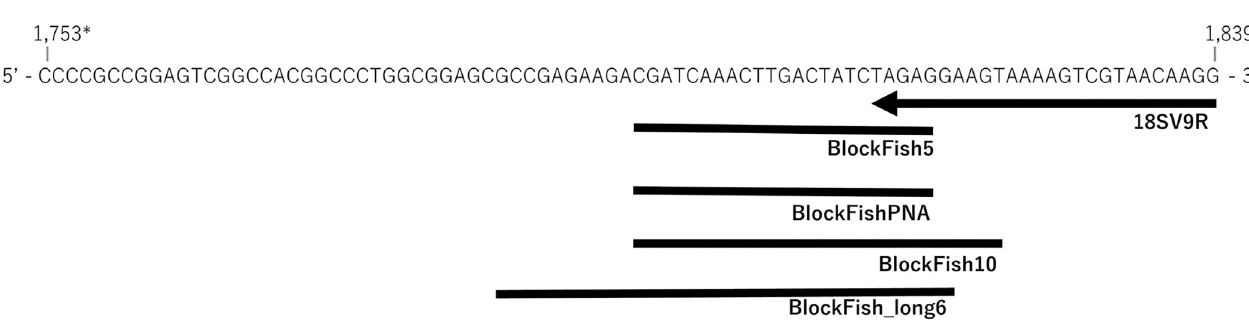
Fig 1. Binding site of each blocking primer and PNA clamp used in this study. The arrow indicates the binding site of the universal reverse primer, 18SV9R. The bars indicate the blocking primers or PNA clamp. � : Base position based on the 18S rDNA sequence of Verasper variegatus (Acc. No. EF126043). https://doi.org/10.1371/journal.pone.0266268.g001 designed (Table 1, Fig 1, and S2 Fig) and used in combination with the eukaryote universal primer, V8f [44] which binds to the 18S rDNA V8 region. The blocking primer and PNA clamp were designed in a region that overlap with 18SV9R and specific to Teleostei (S2 Fig). To suppress PCR amplification of fish-derived 18S rDNA, we developed three blocking primers and one PNA clamp target fish-specific sequences of the 18S rDNA V8–V9 region, namely, BlockFish5, BlockFishPNA, BlockFish_long6, and BlockFish10 (Table 1), thereby annealing to a partially overlapped region with 5, 5, 6, and 10 bp of the universal reverse primer 18SV9R, respectively (Fig 1).